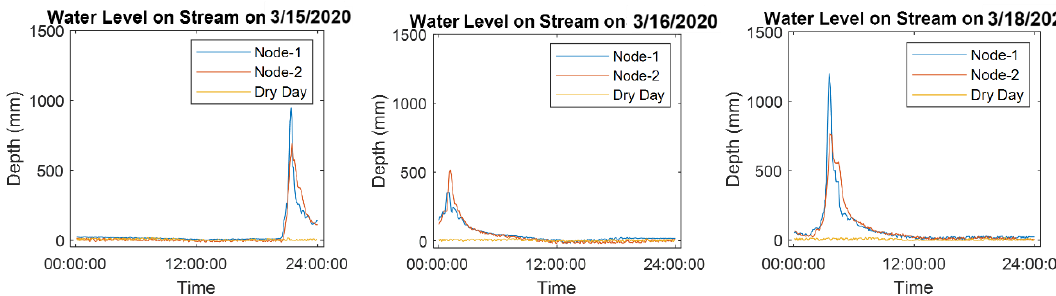
Figure 16. Monitored data in three rainfall events from Node 1 and 2 streamside compared with dry day’s reference water level in yellow.